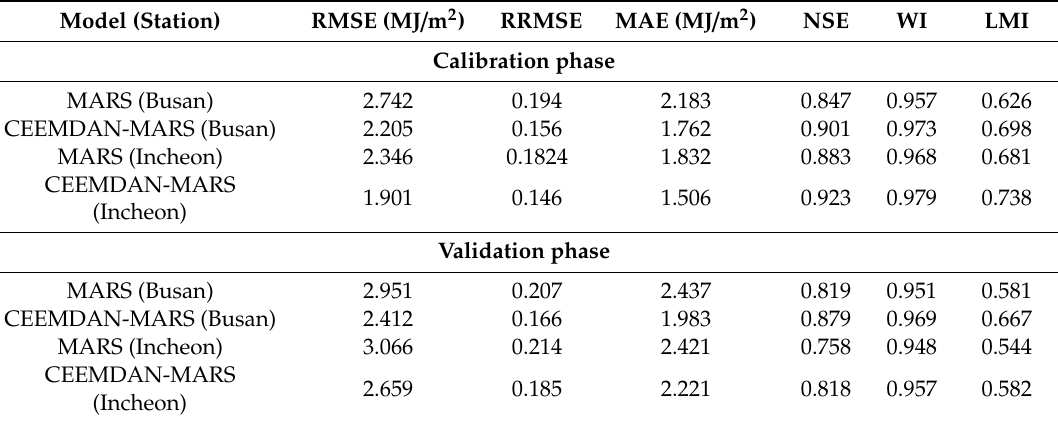
Table 4. Statistical performance of standalone and hybrid MARS models at Busan and Incheon stations. Model (Station)